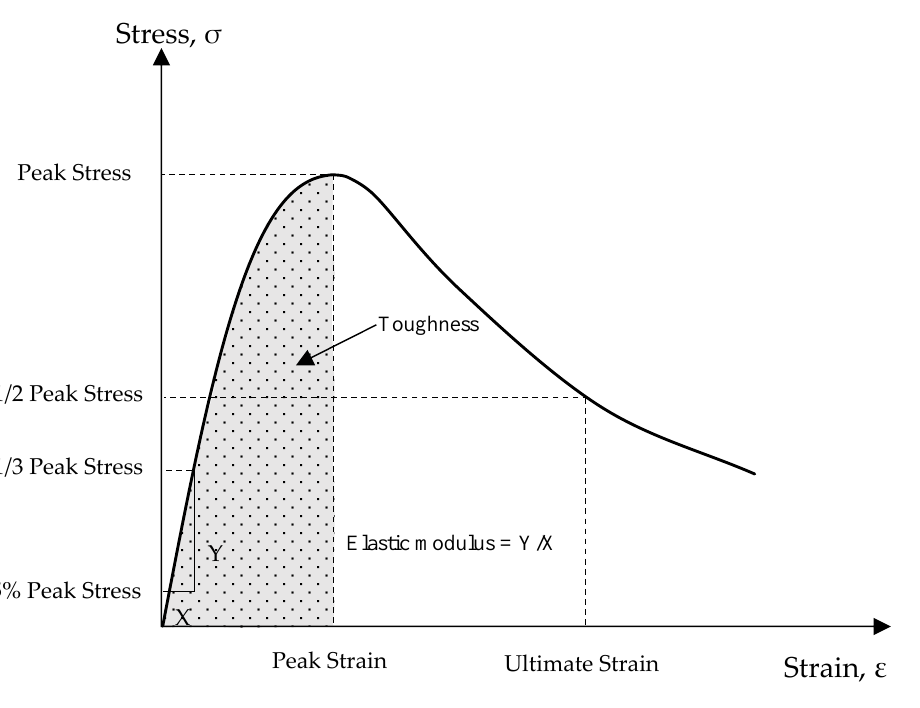
Figure 5. An example of stress–strain curve of concrete.